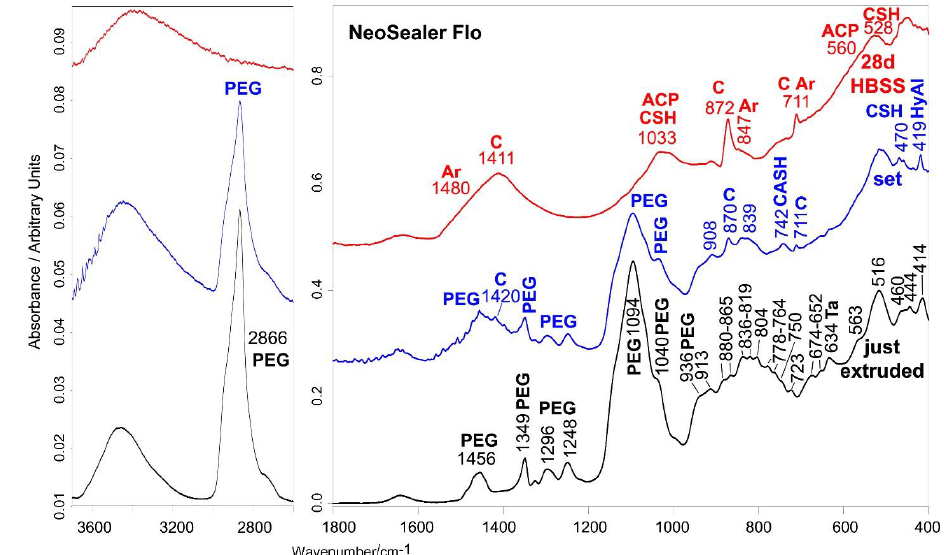
Figure 5. Average IR spectra recorded on just extruded NeoSealer Flo (black) as well as on the surface of set disks before (blue) and after aging in HBSS for 28 days (red). The bands assignable to polyethylene glycol (PEG), tantalite (Ta), calcite (C), aragonite (Ar), hydrated tricalcium aluminate (HyAl), amorphous calcium phosphate (ACP), CSH and CASH phases are indicated. With regard to the 950 – 400 cm − 1 range, band assignments to calcium silicates and aluminates are reported in Table S1, Supplementary Material. PEG and grossite were not reported by the manufacturer in the Material Safety Data Sheet.